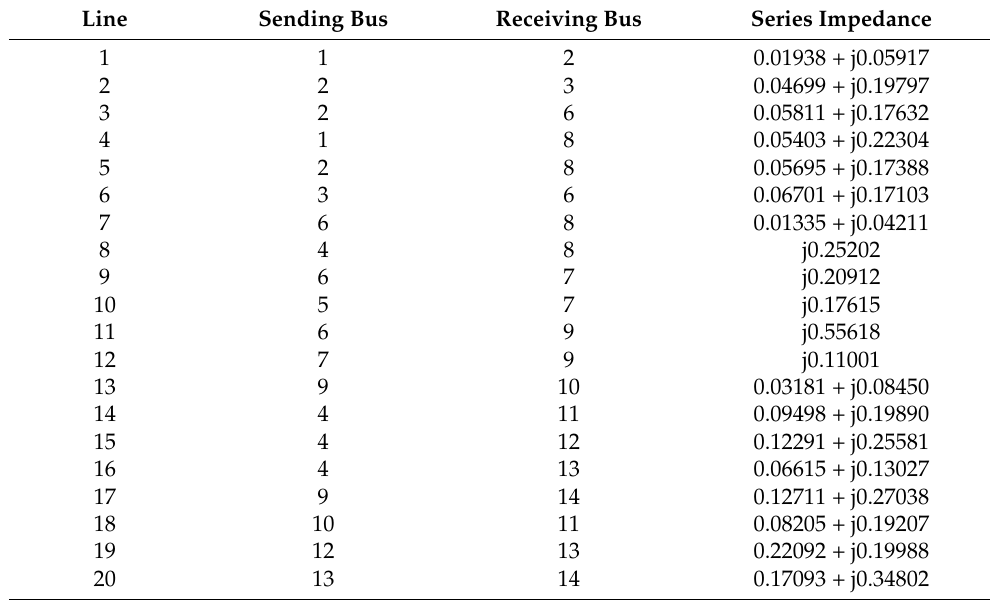
Table 2. Test system line data (in pu).